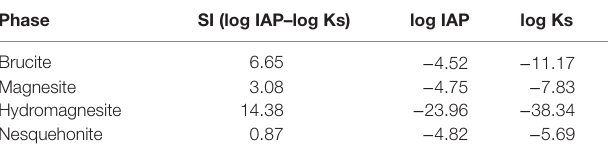
TaBle 2 | saturation indexes (si) of the phases potentially precipitating in the case of the reaction at 25°c and 1 atm of a brine containing 2.4 g l −